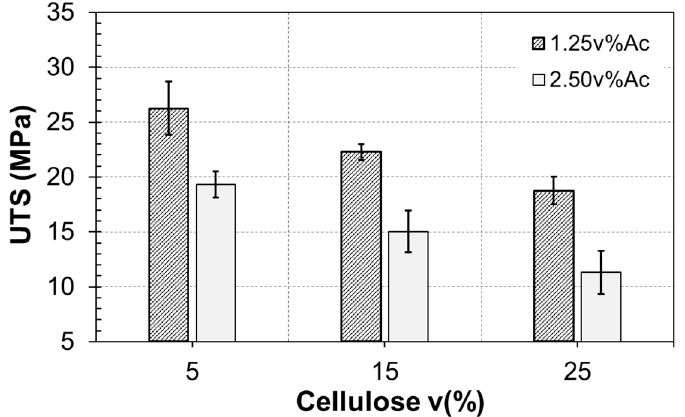
Figure 4. Ultimate tensile strength of bio-composites made of 1.5 v% chitosan/0.5 v% cellulose fabricated with 1.25 v% and 2.50 v% of acetic acid.